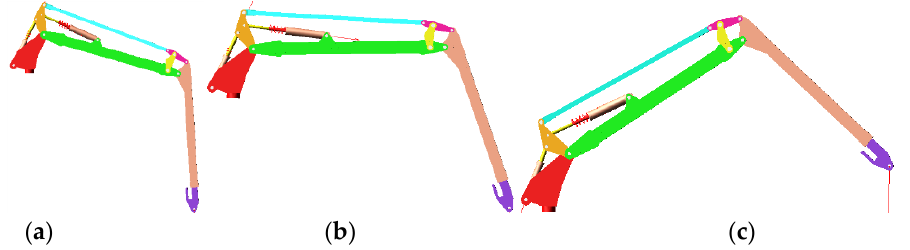
Figure 4. The secondary cylinder luffing and three typical operation conditions. ( a ) Working condition; ( b ) Working condition 5; ( c ) Working condition 6.